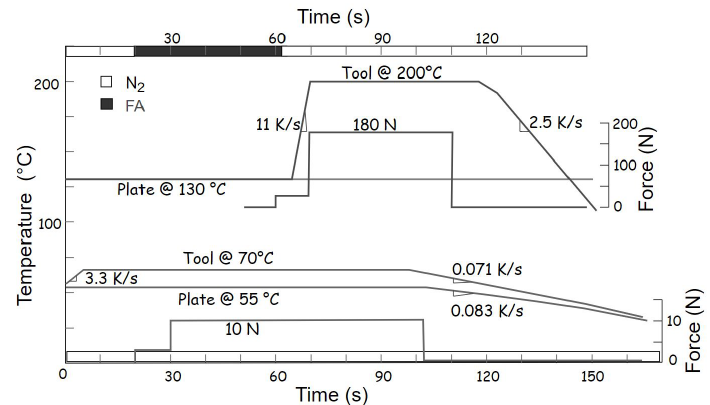
Figure 6. Force and temperature profiles for low-force (lower curve set) and medium-force bonding (upper curve